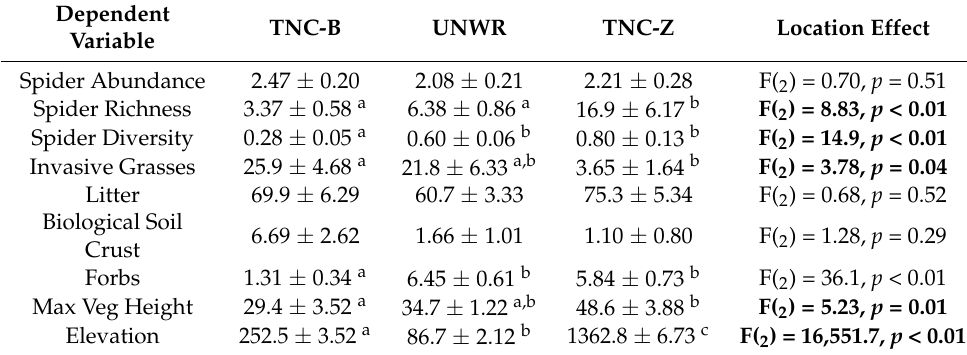
Table 2. Mean ( ± standard error (SE)) spider abundance, rarefied richness, and Shannon diversity and environmental variables of three grasslands in the Pacific Northwest, and location effects using one-way analyses of variance (ANOVAs). Tukey’s honestly significant difference (HSD) test was used for mean comparisons and superscripts represent significantly different means for the post-hoc tests. Location effects in bold are statistically significant at the p < 0.05